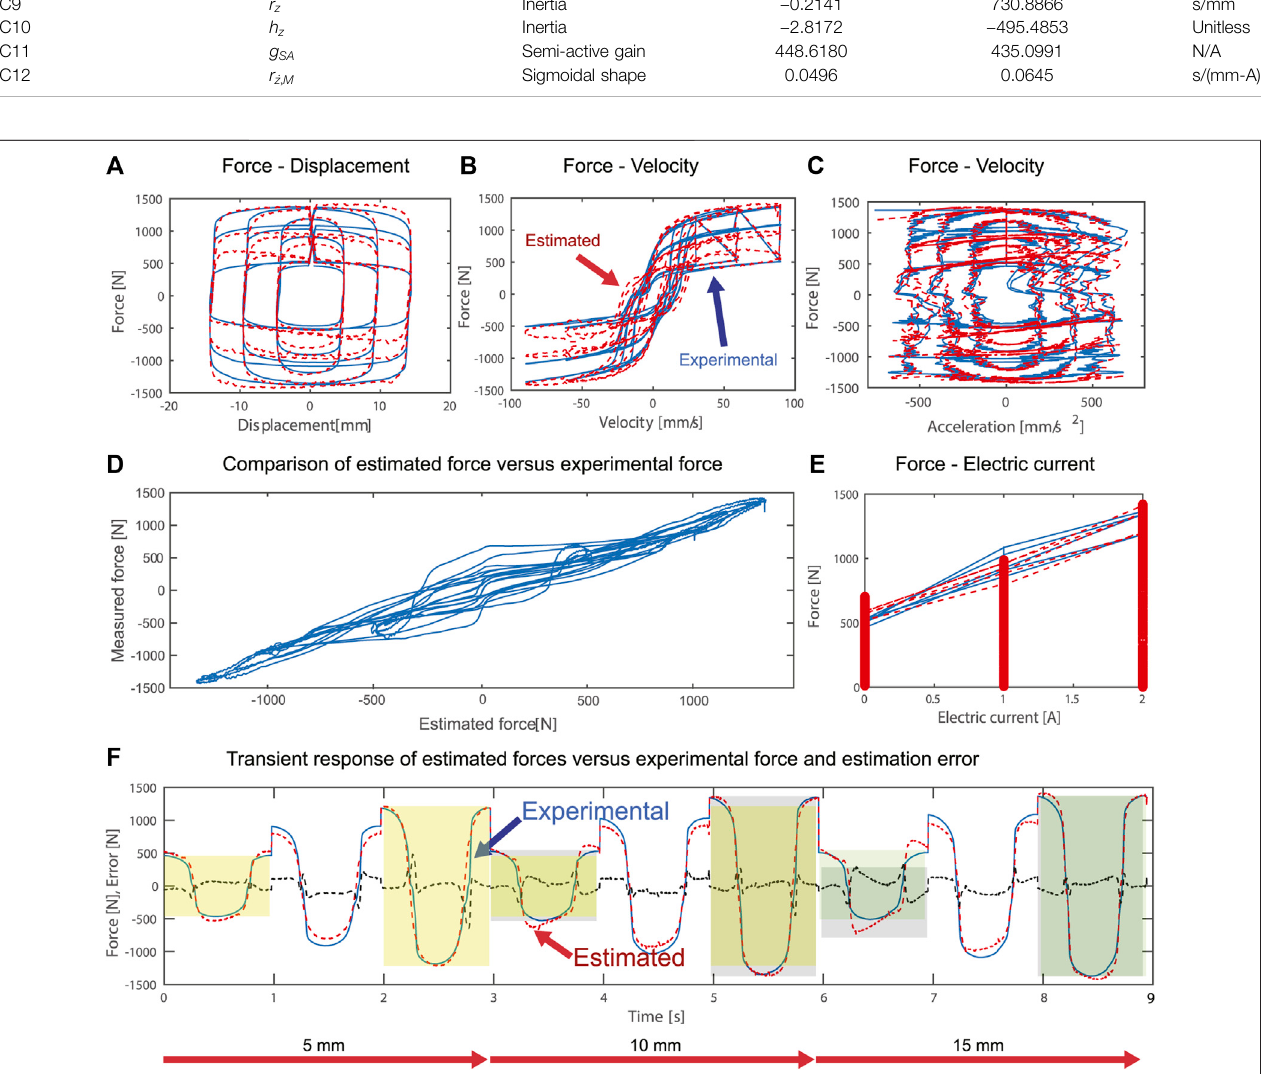
FIGURE 18 | Characteristic diagrams, transient response and estimated vs. experimental forces plots for the Complete-Complete MR damper model.